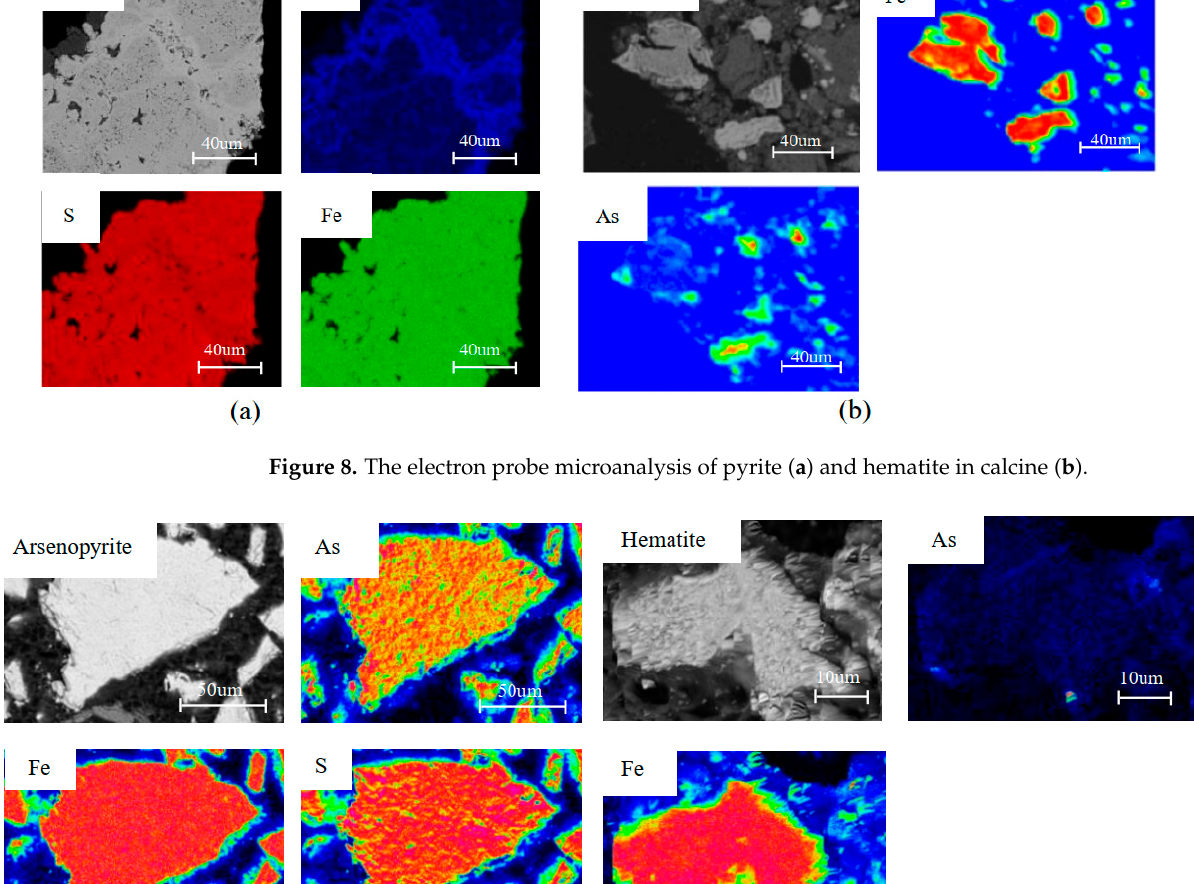
Figure 10. The microstructure of hematite in calcine. The mineral phase evolution during roasting is followed by a change in the occur- rence state of gold. The change in the occurrence state of gold directly affects the gold leaching efficiency. The occurrence of gold is determined via diagnostic leaching. The occurrence of gold in different phases of the arsenious and sulfur-bearing Carlin-Type gold ore and the calcine is shown in Figure 11. It can be seen from Figure 11 that only 16.88% of gold is exposed in raw ore, with up to 61.6% of the gold encapsulated in sul- fides. After roasting, the calcin contains up to 56.4% exposed gold, iron ox- ide-encapsulated gold up to 31.50% and sulfide-encapsulated gold almost reduced to 0 %. This will facilitate the subsequent gold leaching process. 16.88